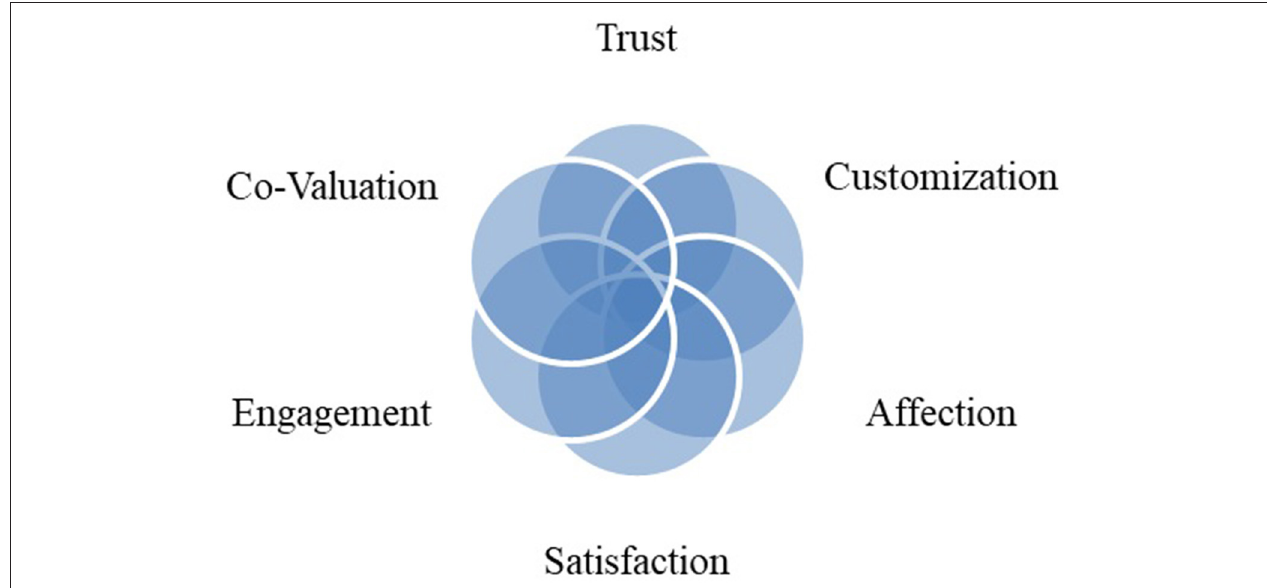
FIGURE 1 | Relationship of e-shared value, trust, and affection